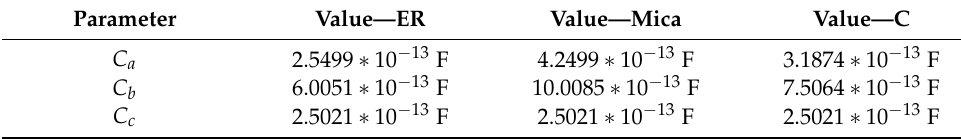
Table 3. Capacitive Model’s Parameters (h, 2 r).